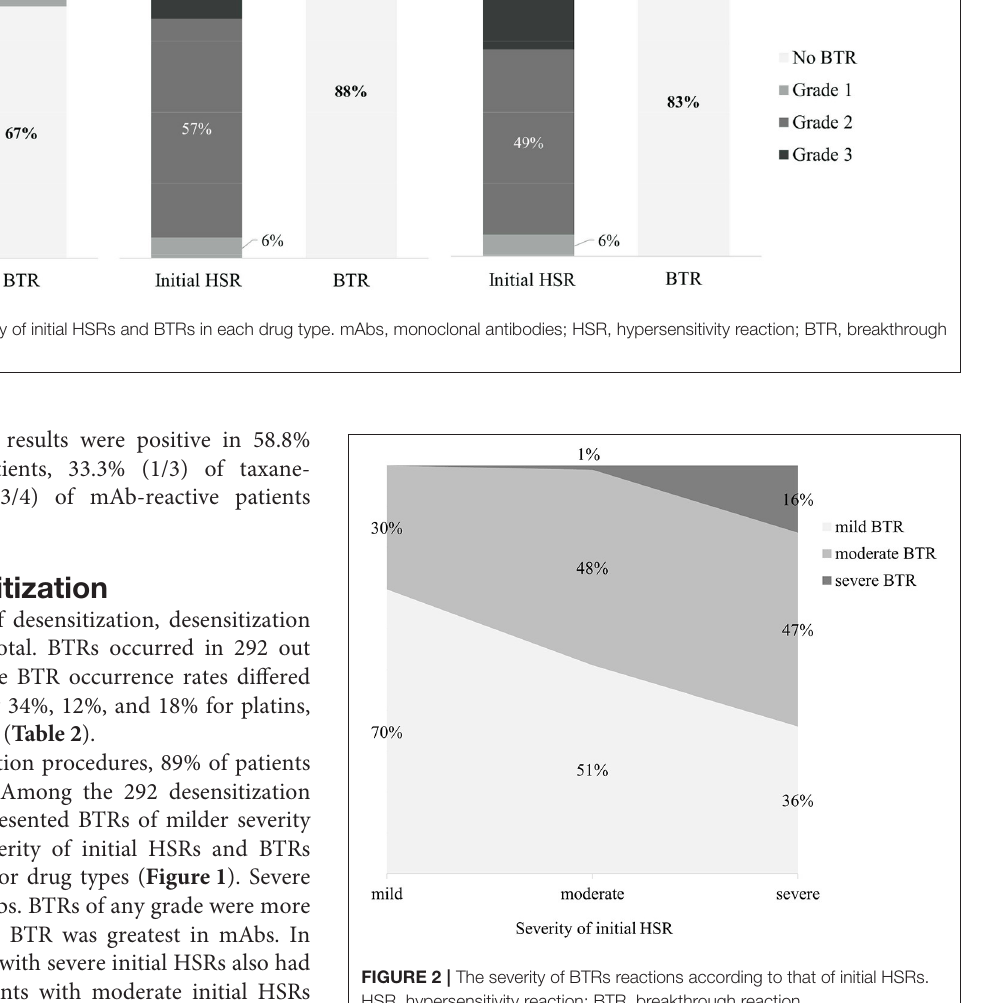
and fever/chills were the most common presentations of the initial HSRs; 8% of them (11% for rituximab and 5% for the other mAbs combined) occurred solely as fever/chills without other